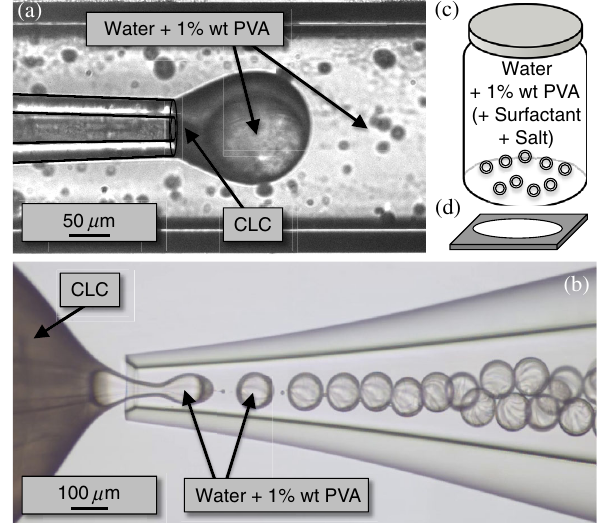
FIG. 8. Fabrication of CLC shells. CLC double emulsions are produced using either a microfluidic device with two nested coaxial capillaries, in the case of surfactant experiments (a), or a microfluidic device with two tapered capillaries facing opposite directions, for temperature experiments (b). The inner and outer phases are water with 1% wt PVA. The middle phase is CLC. The shells are collected into a vial containing water and 1% wt PVA (c). For surfactant experiments, the shells are then pipetted into a vial containing water, 1% wt PVA, 0.1-M NaCl, and varying concentrations of SDS. After about 10 minutes, the CLC shells are pipetted into a viewing chamber that is then sealed to prevent evaporation